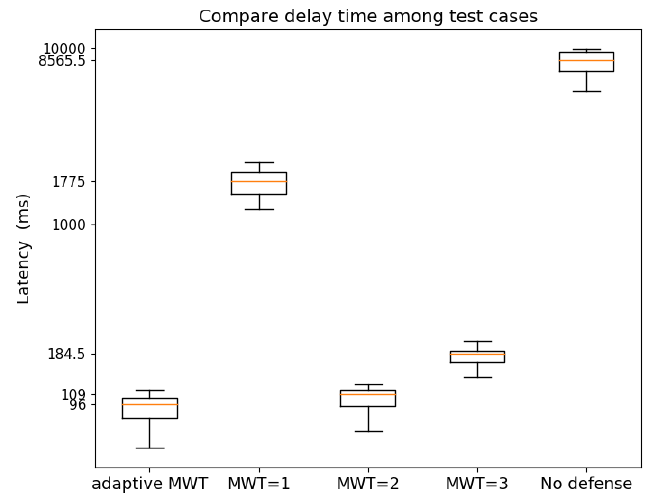
Figure 13. Latency of normal